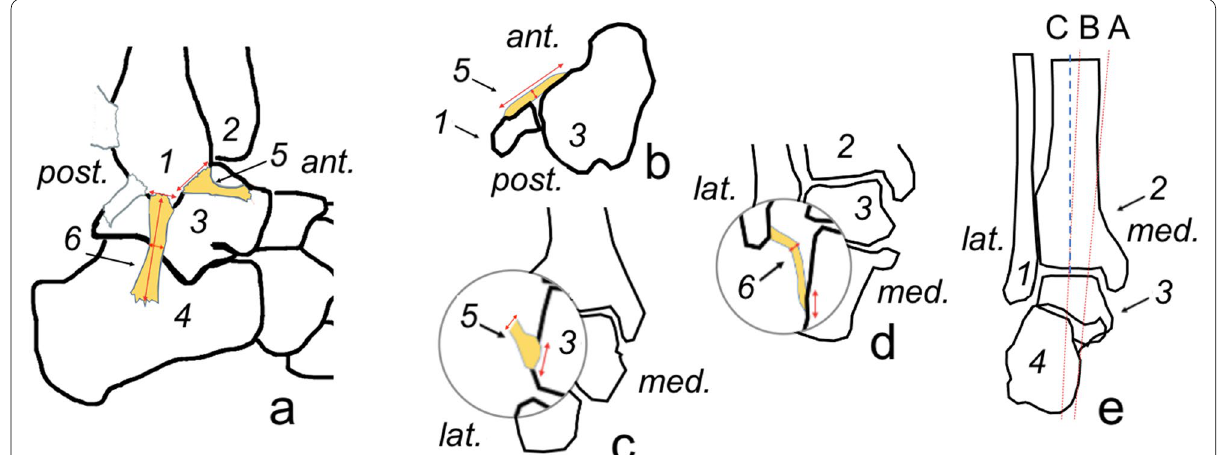
Fig. 3 Method of measuring the anterior talofibular ligament and the calcaneofibular in our study. A Sagittal projection, view from the lateral side; b axial section; c and d coronal section. Ant., anterior; post., posterior; med., medial; lat., lateral; 1, the fibula; 2, the tibia; 3, the talus; 4, the calcaneus; 5, the ATFL; 6, the